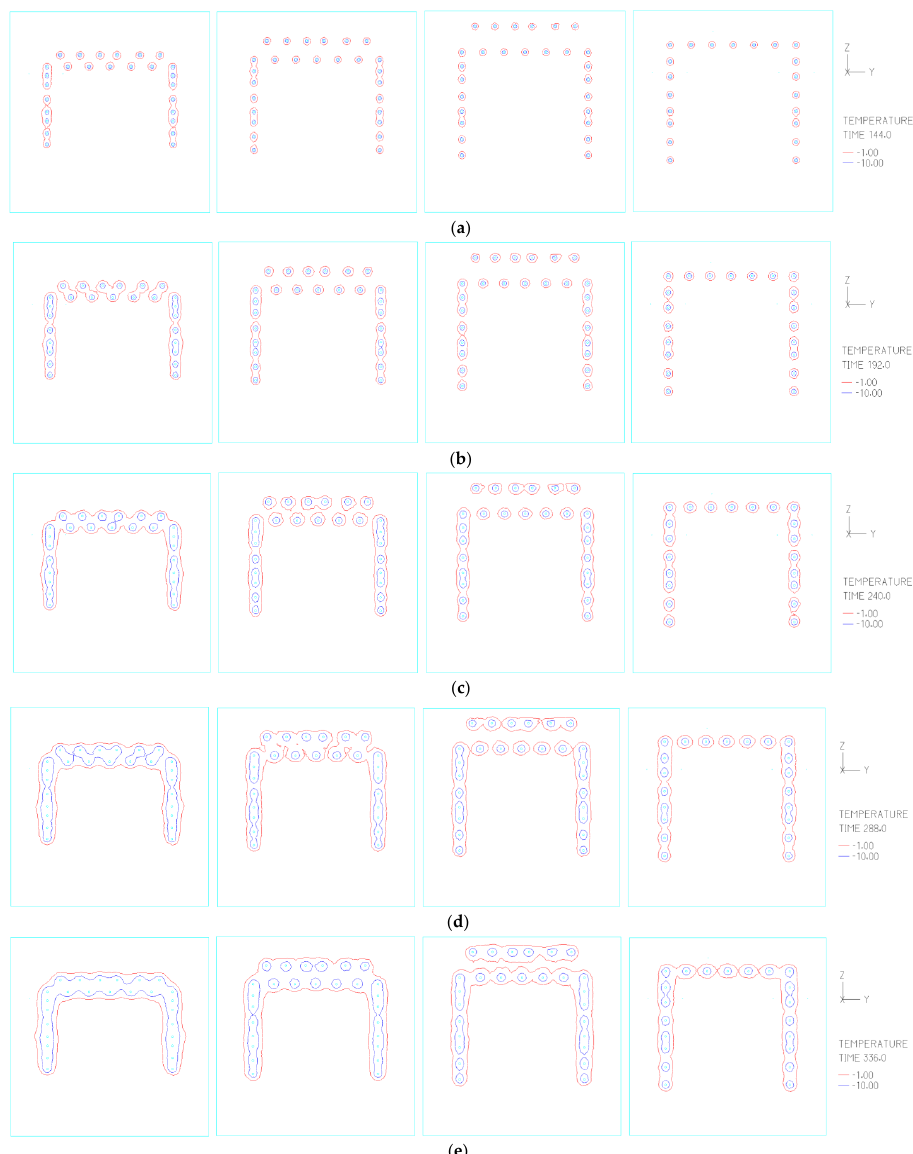
Figure 7. Isotherms for − 1 and − 10 °C for various freezing times. ( a ) Actively frozen for 6 days, ( b ) actively frozen for 8 days, ( c ) actively frozen for 10 days, ( d ) actively frozen for 12 days, ( e ) actively frozen for 14 days.